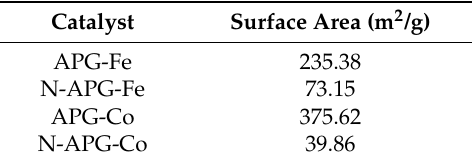
Table 1. Surface area of doped and non-doped apricot catalysts with Fe and